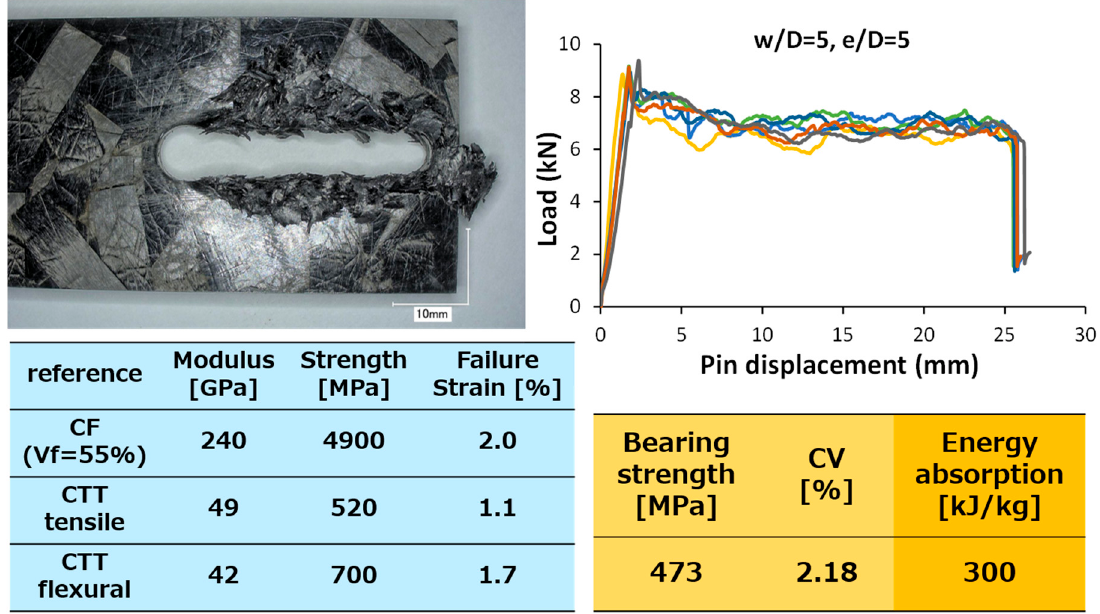
Figure 10. Bolt bearing and energy absorption properties of CTTs.